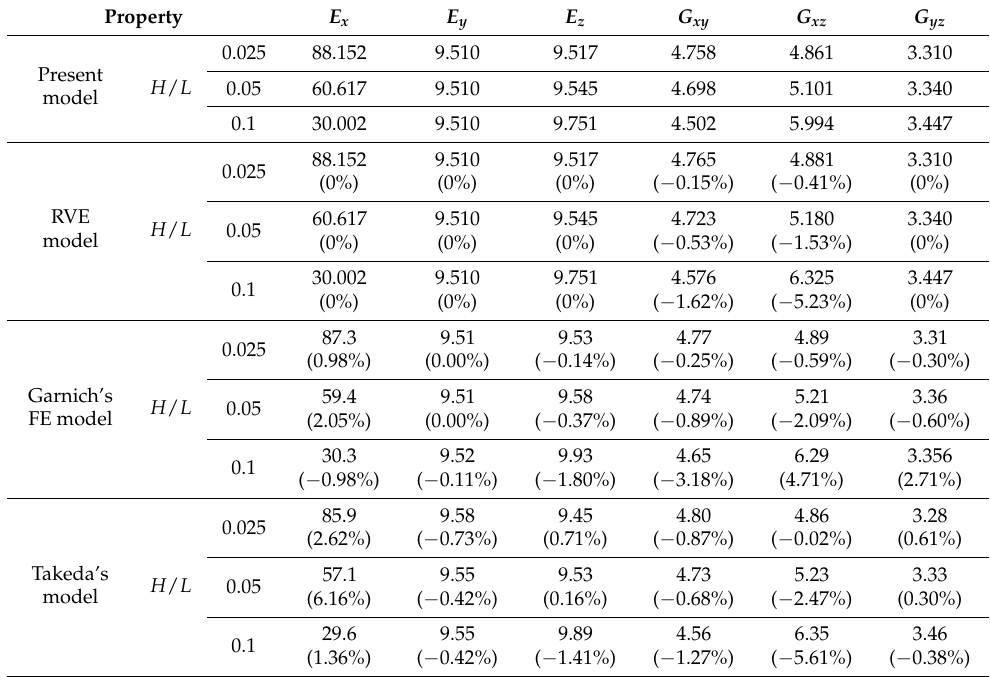
Table 3. Effective elastic properties of a unidirectional laminate with wrinkles in different